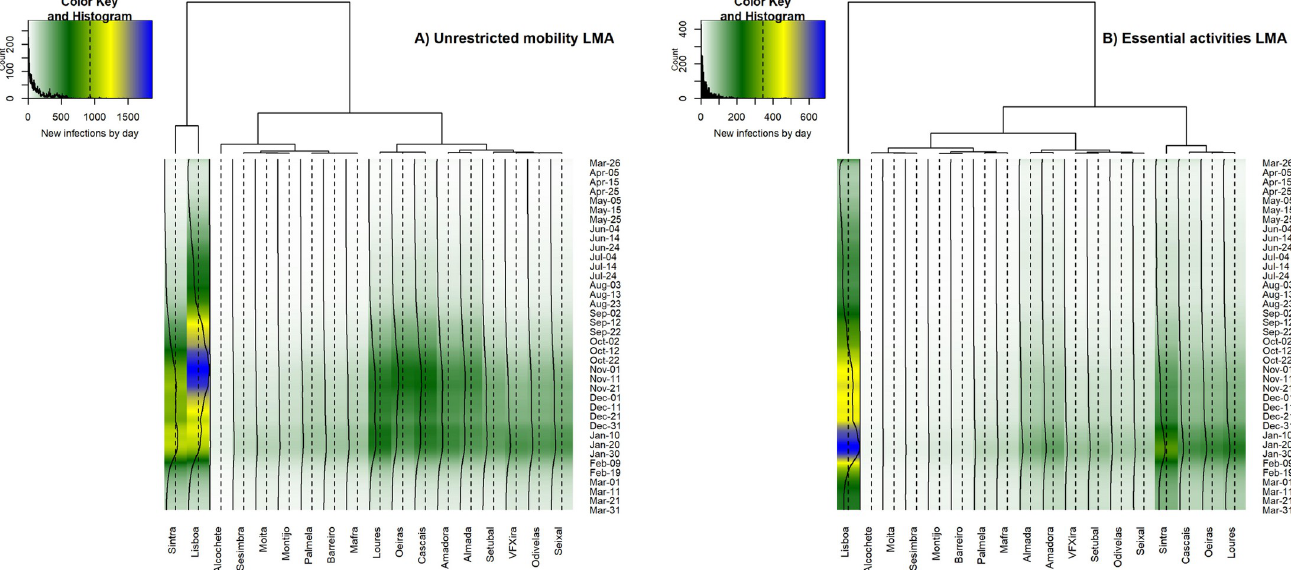
PLOS ONE | https://doi.org/10.1371/journal.pone.0274286 September 9,